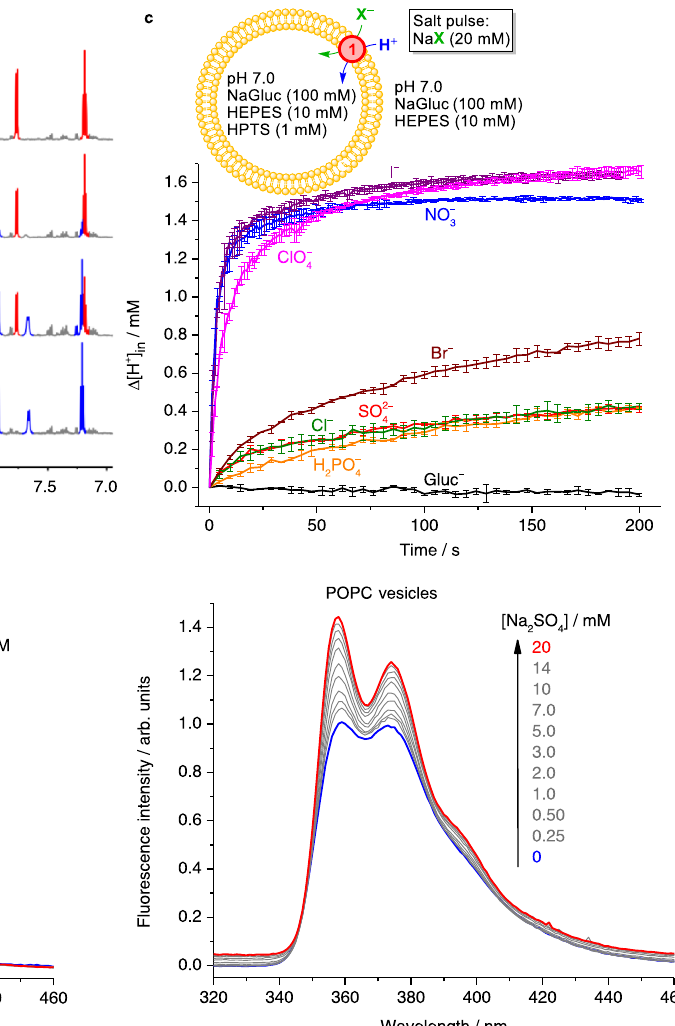
Fig. 2 | Anion binding and transmembrane anion transport by macrocycle 1. a 1 H NMR (600MHz) titration of 1 (0.3mM) with TBA 2 SO 4 in DMSO- d 6 /0.5% H 2 O. Signalsfromfree 1 andthe 1 – SO 4 2 – complexareshowninblueandred,respectively. Impurities are present from partial degradation of 1 during SO 4 2 – removal. b Fluorescence titration of 1 (50nM) with Na 2 SO 4 in C12E8 (2 mM) micelles (left) and POPC (0.2 mM) vesicles (right) in H 2 O. λ ex =265nm. c Transmembrane H + /X –